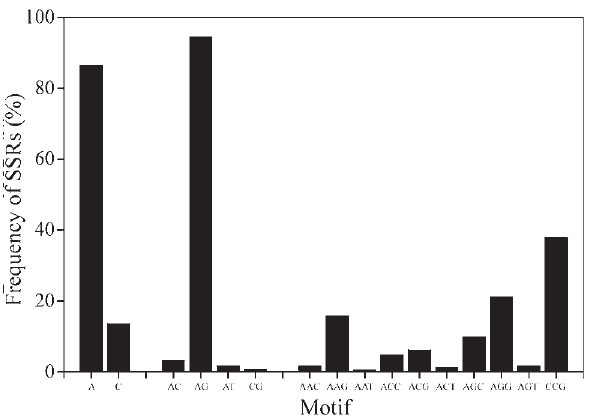
Figure 1 - Frequency of SSRs according to motifs, mined from the FOR- ESTs database (11,534 SSRs).